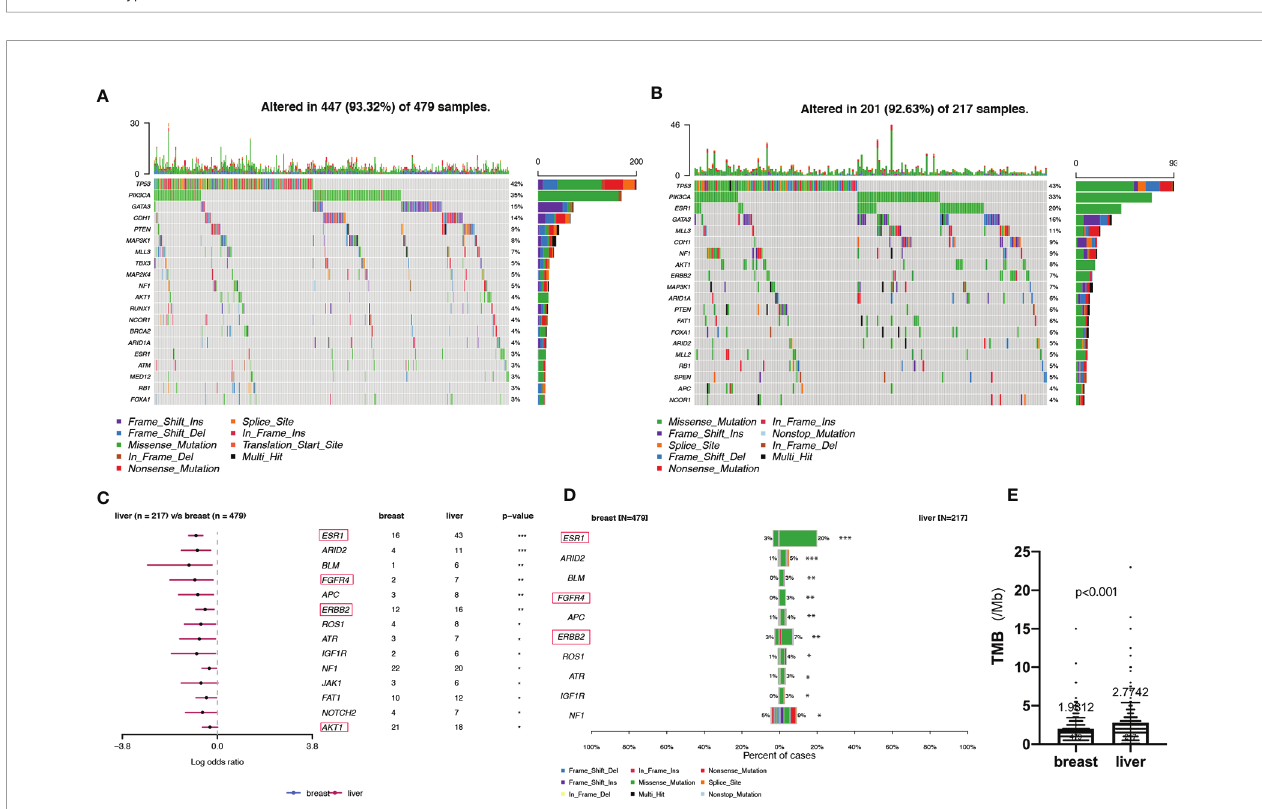
FIGURE 5 | Somatic mutations in pBCs and LMs. (A, B) Top 20 SMGs in pBCs and LMs, respectively. (C) Comparison of SMGs between pBCs and LMs. (D) Comparison of the top 10 SMGs between pBCs and LMs. (The genes in the red box represent the driver genes, *p < 0.05, **p < 0.01, ***p < 0.001) (E) Comparison of TMB between pBCs and LMs (p < 0.001). SMG, signi fi cantly mutanted gene; TMB, Tumor Mutation